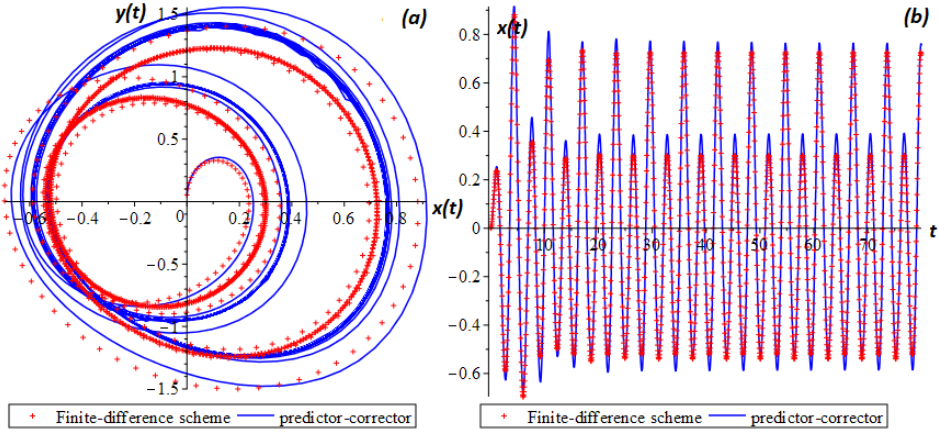
Figure 6. Phase trajectory ( a ) and waveforms ( b ) obtained from schemes (10) and